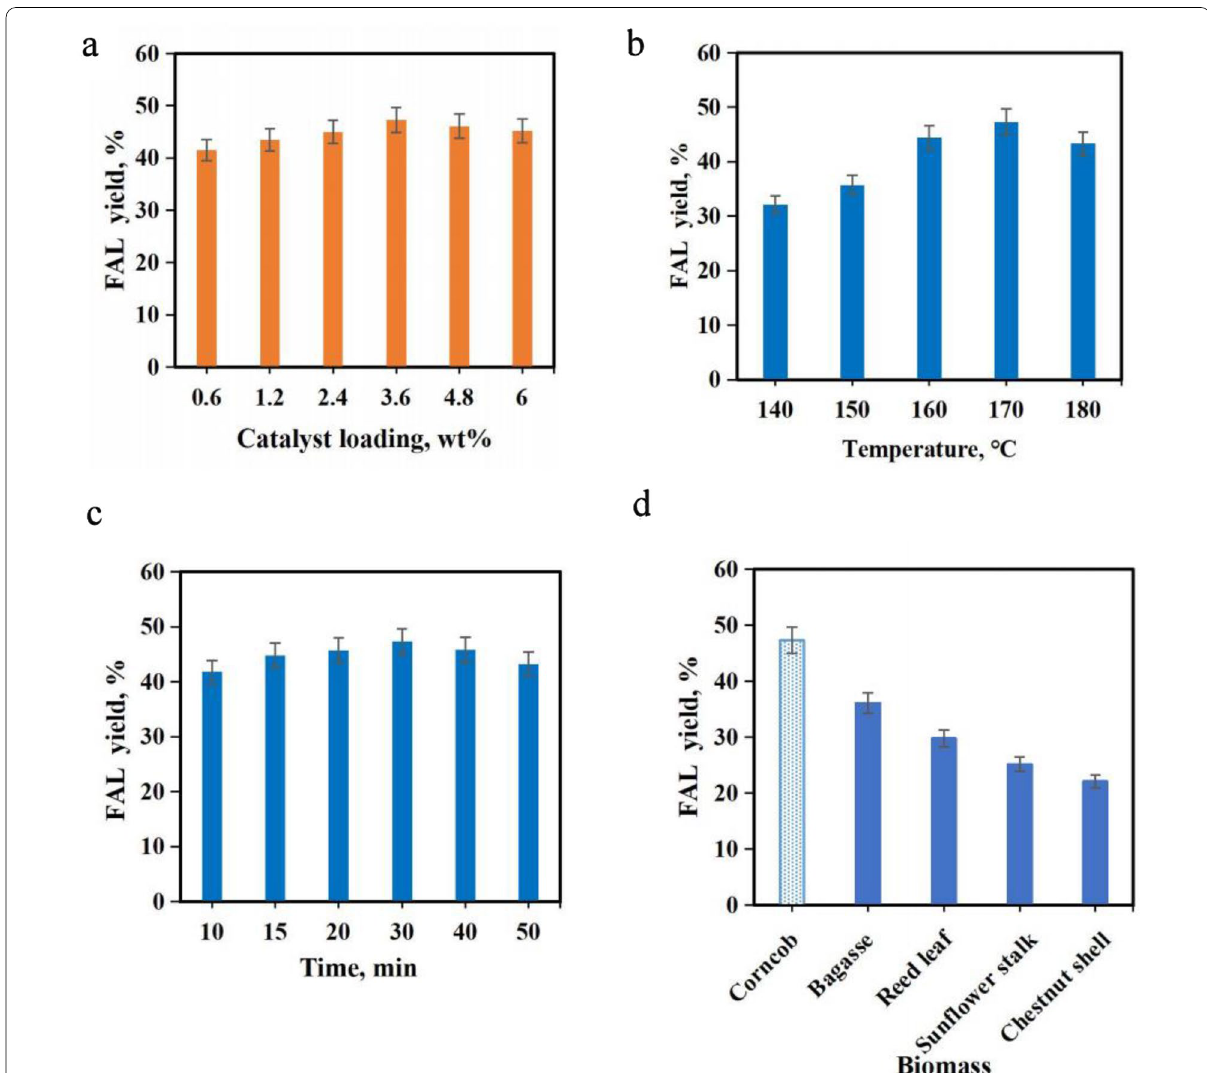
Fig. 3 Effects of the Sn‑GP dose (0.6–6.0 wt%) on FAL yields (Corncob 3.0 g, maleic acid 0.5 wt%, 170 °C, 0.5 h, water 40 mL) ( a ); Effects of reaction temperature (140–180 °C) on FAL yields (Corncob 3.0 g, Sn‑GP 3.6 wt%, maleic acid 0.5 wt%, 0.5 h, water 40 mL) ( b ); Effects of reaction time (10–50 min) on FAL yields (Corncob 3.0 g, Sn‑GP 3.6 wt%, maleic acid 0.5 wt%, 170 °C, water 40 mL) ( c ); Effects biomass types on FAL yields (Biomass 3.0 g, Sn‑GP 3.6 wt%, maleic acid 0.5 wt%, 0.5 h, 170 °C, 0.5 h, water 40 mL) ( d